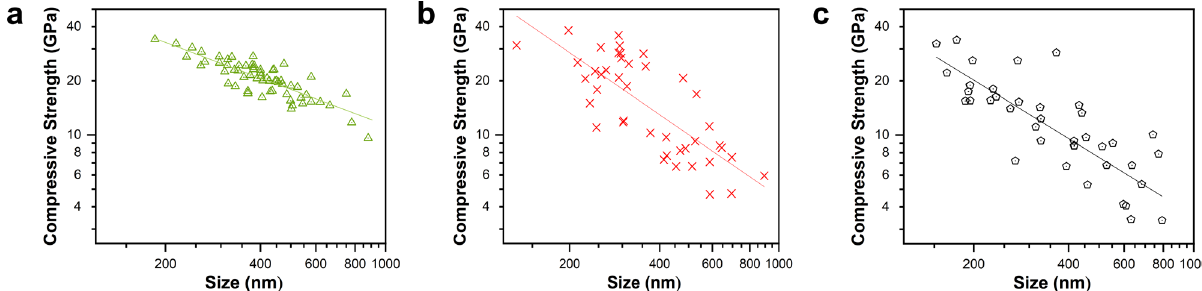
Fig. 4 Effect of alloying on the mechanical strength of nanoparticles. Experimental compressive strength as a function of particle size for ( a ) Ni, ( b ) Ni- 0.3Co, and ( c ) Ni-0.5Co. The straight lines show linear fi